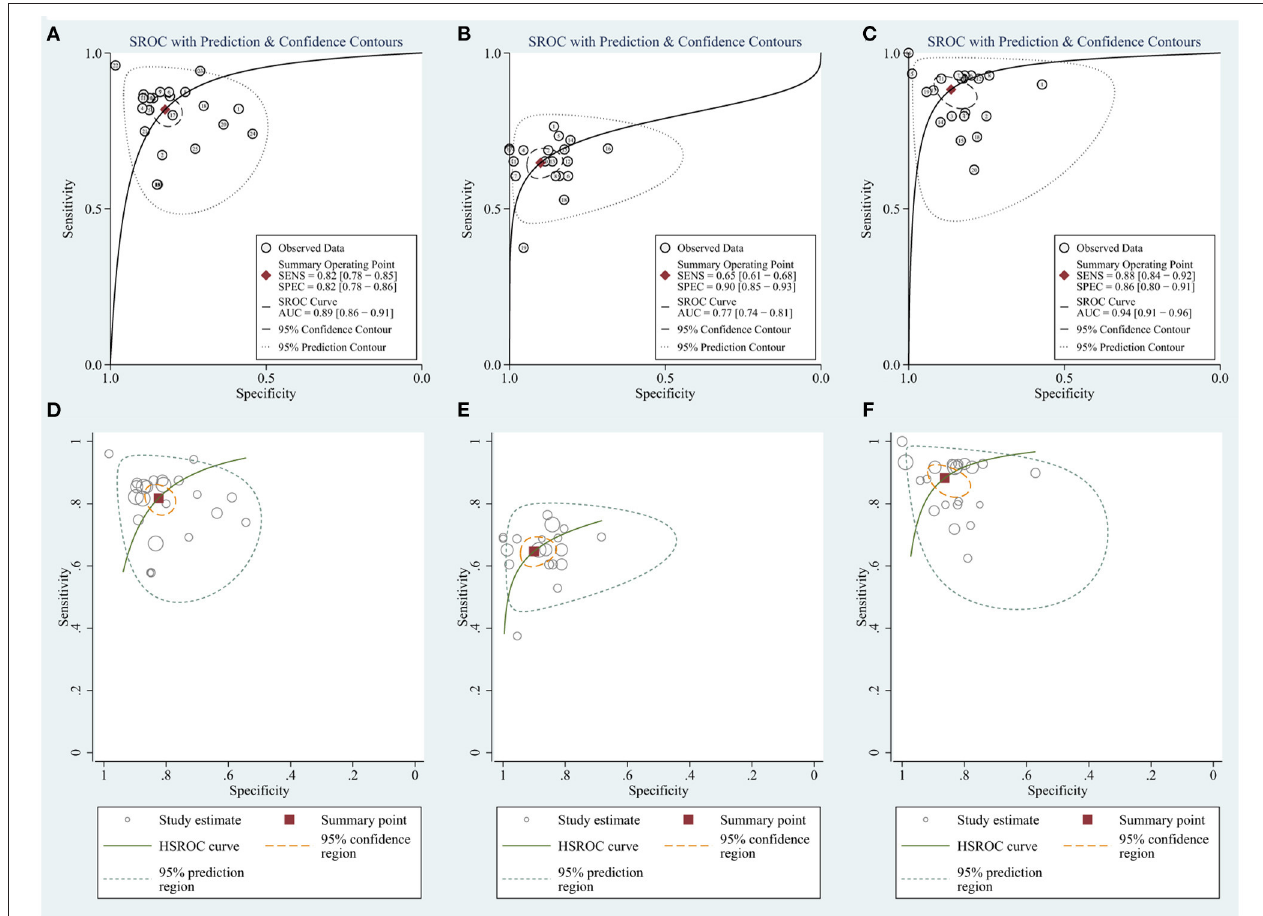
FIGURE 4 | The summary receiver operator characteristic (SROC) for (A) circRNAs. (B) AFP. (C) Combination of circRNAs and AFP and the hierarchical summary receiver operating characteristics (HSROC) for (D) circRNAs. (E) AFP. (F) Combination of circRNAs and AFP.